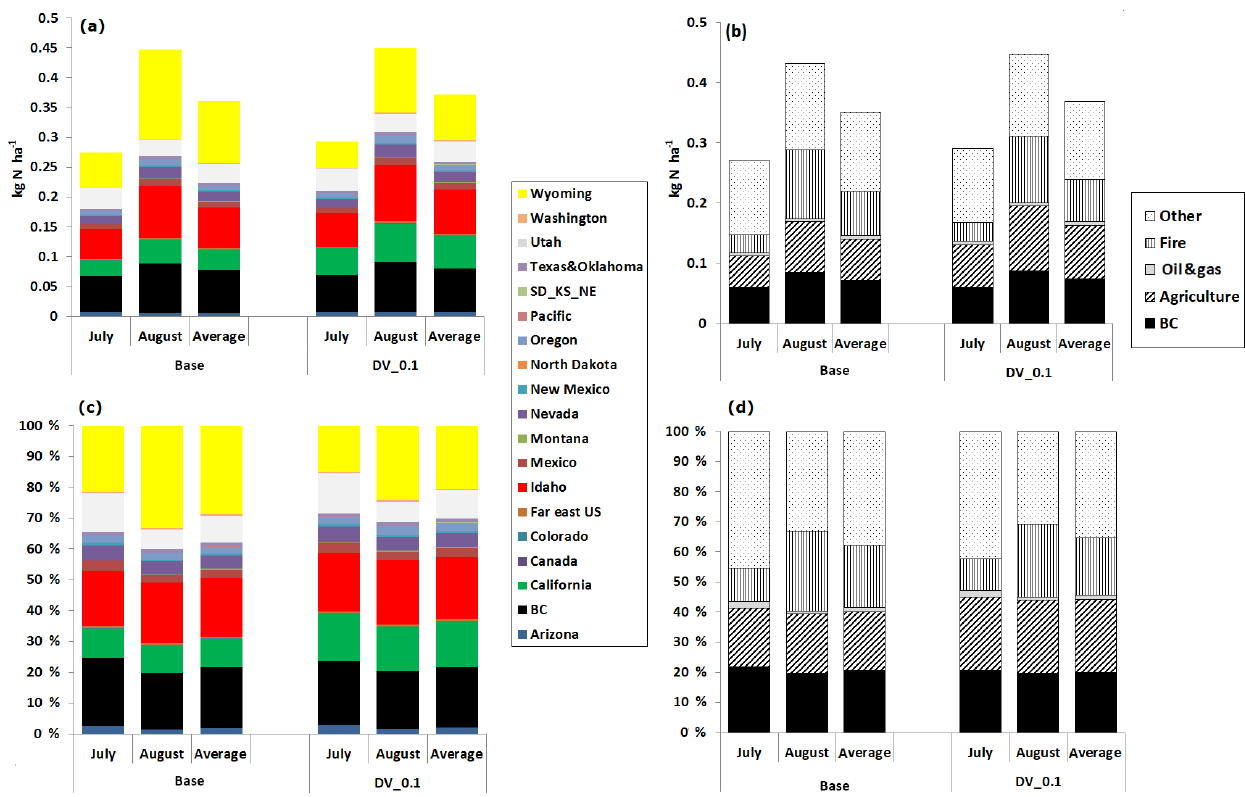
Figure 11. The sensitivity of NH 3 dry deposition velocity ( a, b “base” case; c, d “DV_0.1” case with NH 3 dry deposition velocity slowing down) to source apportionment results over the GYA during July–August 2011. Panels (a) and (c) show the contributions by source region as an absolute and as a percentage while (b) and (d) show the contributions by source sector.